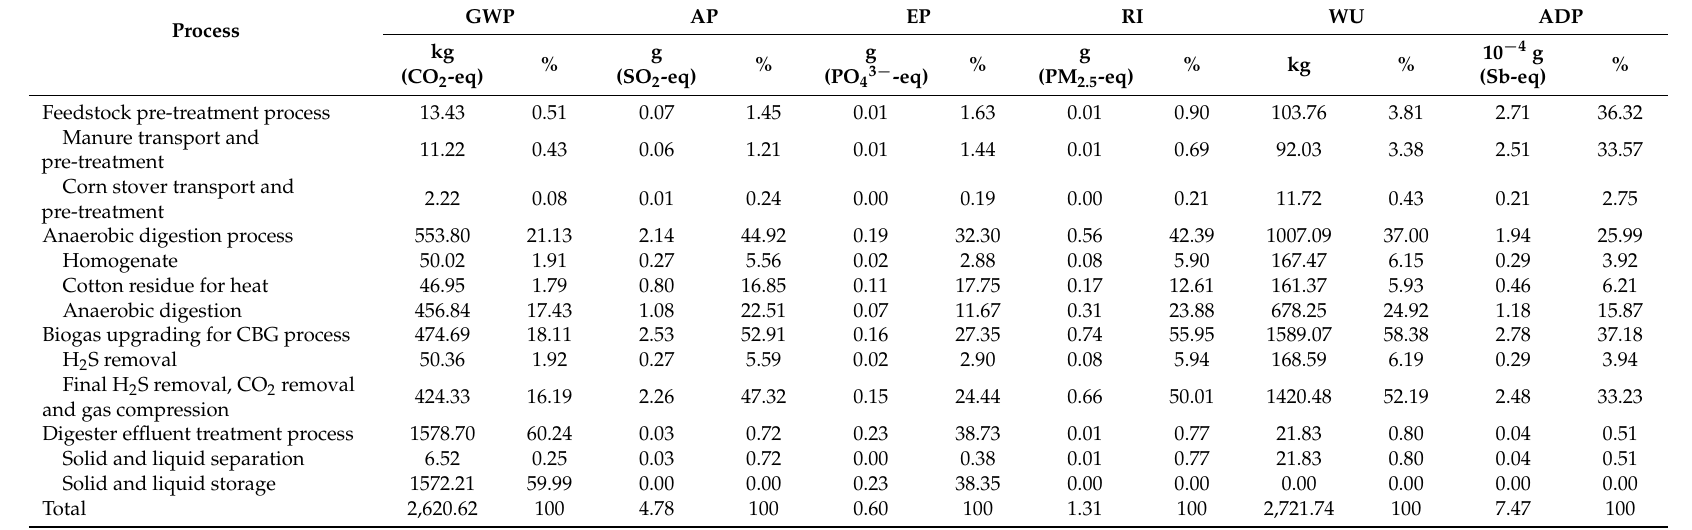
Table 4. Life cycle global warming potential (GWP), acidification potential (AP), eutrophication potential (EP), respiratory inorganics (RI), water use (WU) and abiotic depletion potential (ADP) performances of different processes for 1 m 3 CBG